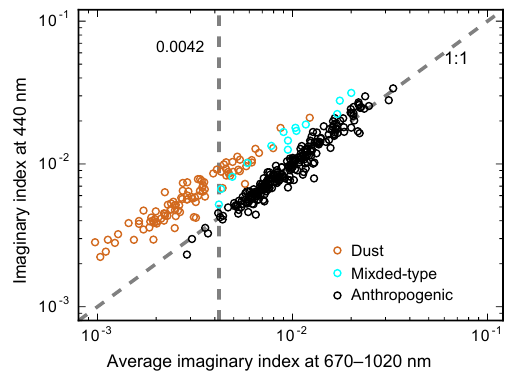
Figure 2. The imaginary refractive index at 440nm versus the av- erage of the imaginary refractive indices at 675, 870, and 1020nm for dust, mixed-type, and anthropogenic aerosols over worldwide AERONET sites. Only those sites with a sample number of 50 and higher were averaged and shown in the figure.